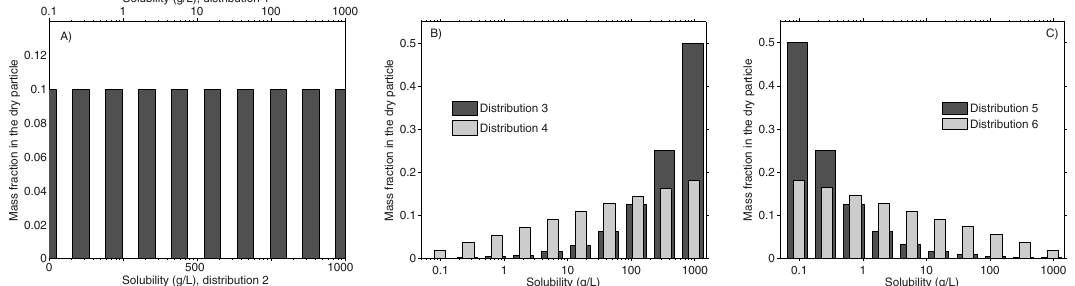
Figure 2. Examples of solubility distributions used in the calculations for saturation concentrations ranging from 0.1 to 1000gL − 1 . (a) Linear and logarithmic flat distributions; (b) linear and logarithmic increasing distributions; and (c) linear and logarithmic decreasing distributions. The numbers of the distributions refer to the numbering in Table 2 (see Sect. 2.1.4).